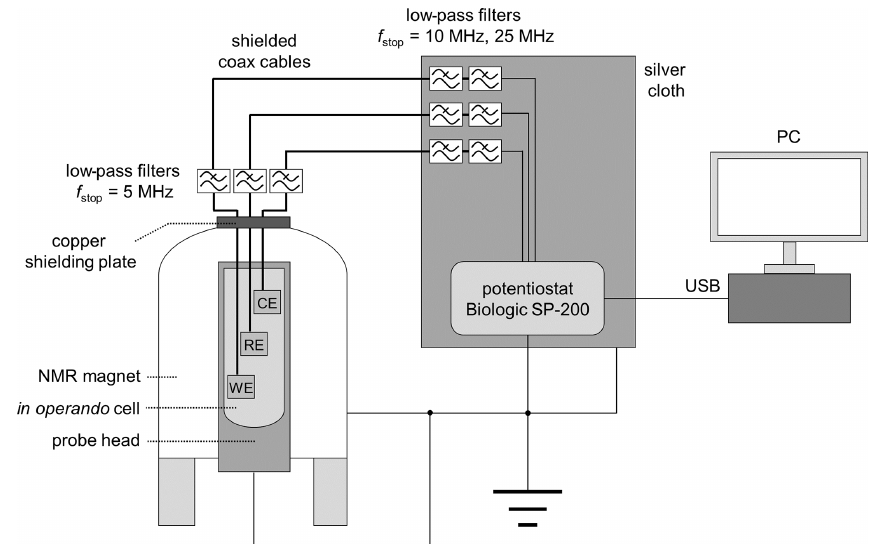
Figure 3. Schematic drawing of the in operando NMR electrolysis setup with shielding, RF filters, and